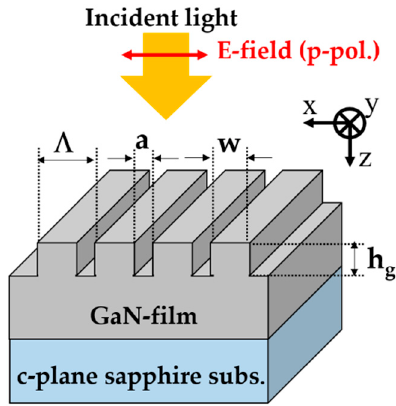
Figure 1. Schematic diagram of the monolithic GaN- high-contrast grating (HCG) on c -plane sapphire substrate.